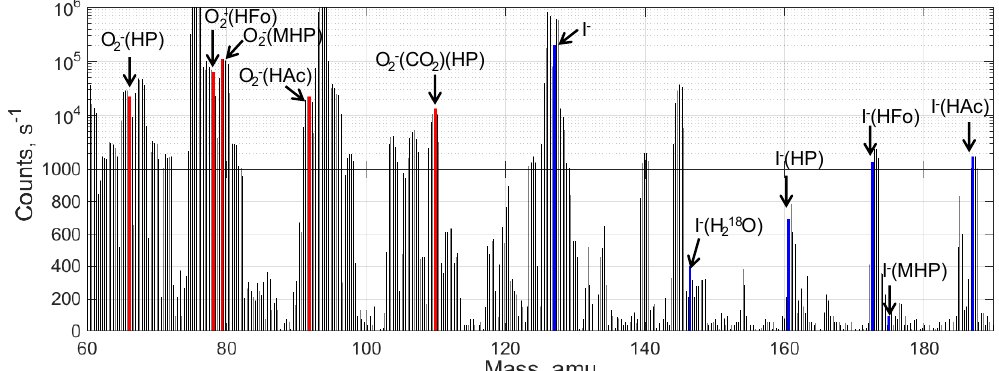
( CO 2 ) masses. Figure 2. PCIMS laboratory standard addition mass spectrum for the multi-reagent ion system showing the I − and O − 2 The PCIMS was operated at ambient pressure (1013hPa) and a 370ppm reaction cell water vapor mixing ratio. The mass dwell time ( CO 2 ) masses of interest are marked by red vertical lines and listed in increasing numerical order. These masses, was 50ms. The O − 2 ( HP ) ), m/z 78 (O − ( HFo ) ), m/z 80 (O − ( MHP ) ), m/z 92 (O − ( HAc ) ), and m/z 110 and the corresponding ion clusters, are m/z 66 (O − 2 2 2 2 ( CO 2 )( HP ) ). The I − masses of interest are marked by blue vertical lines and listed in increasing numerical order. These masses, and (O − 2 the corresponding ion clusters, are m/z 127 (I − ), m/z 147 (I − ( H 18 O ) ), m/z 161 (I − ( HP ) ), m/z 173 (I − ( HFo ) ), m/z 175 (I − ( MHP ) ), and 2 m/z 187 (I − ( HAc ) ). Note the count scale is linear up to 1000 and logarithmic above